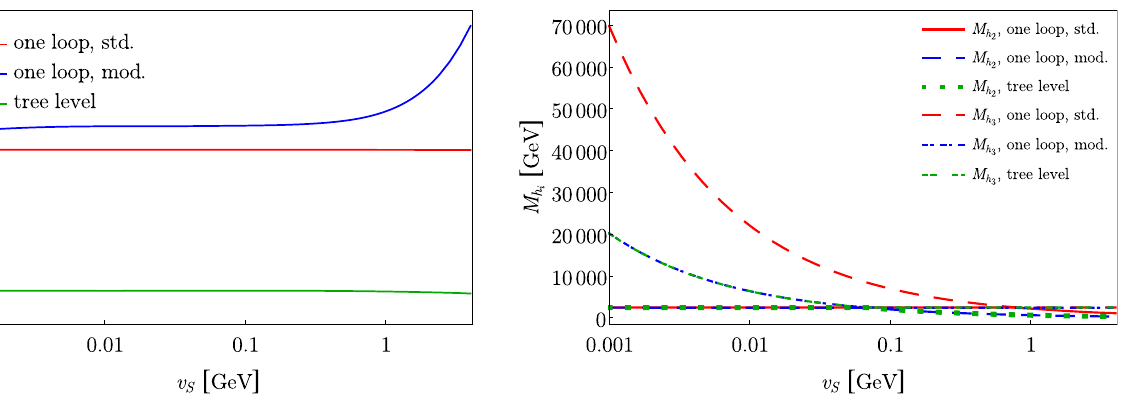
Fig. 8 M h (left) and M h and M h (right) as a function of v S in while the red and blue curves correspond to the pole masses computed 1 2 3 a scenario of the μ NMSSM. The other inputs are taken as follows: at one loop, respectively with the standard and modified approaches to λ = κ = 0 . 1, T λ = 200 GeV, T κ = − 10 GeV, μ = 100 GeV, the tadpoles. The colour coding of the lines remains the same for all B μ = 6 · 10 5 GeV 2 . Tree-level values are shown with green curves, figures in this